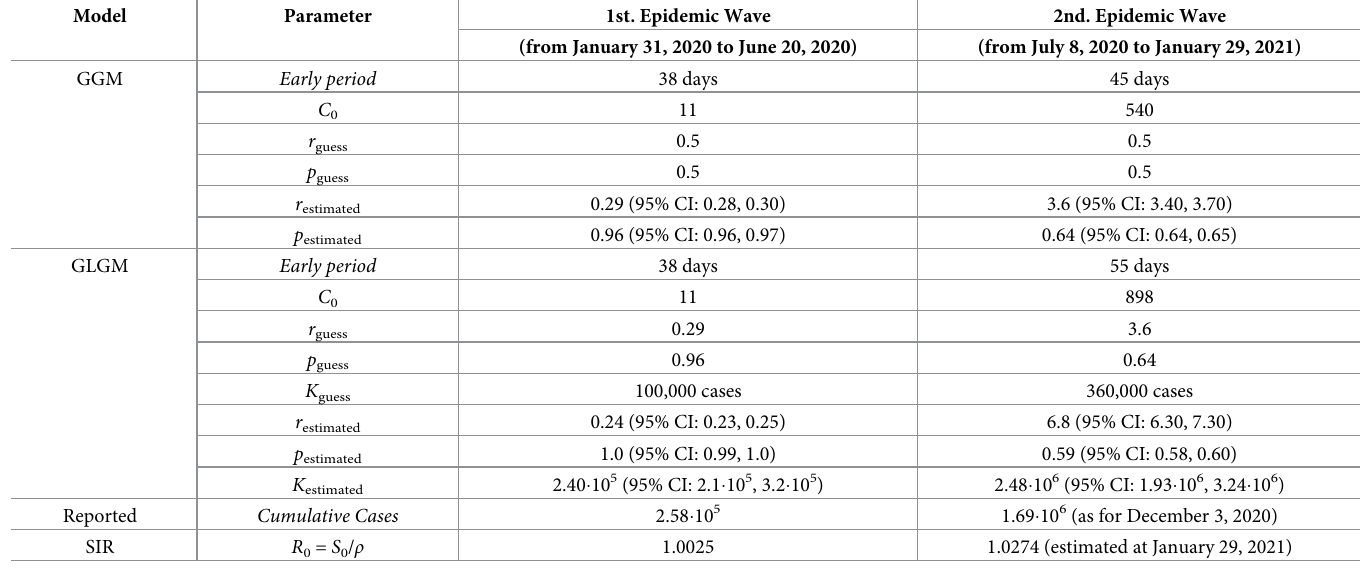
Table 1. Main parameters of epidemic